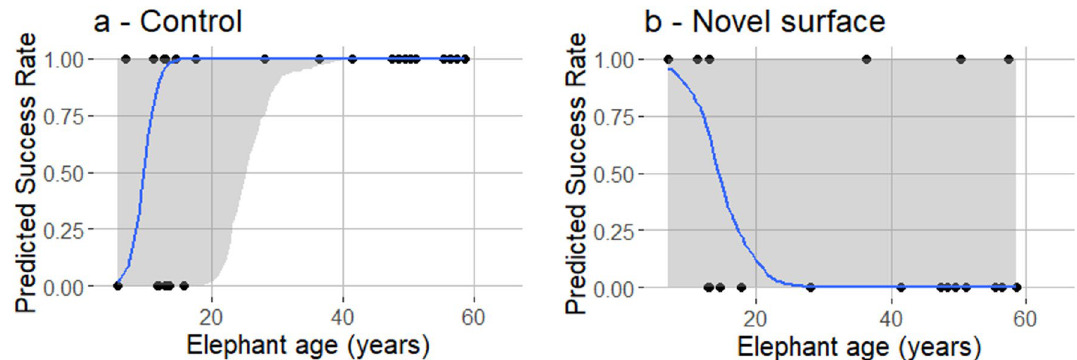
Figure 4. Predicted success rate depending on the task and elephant age (years), ( a ) control; ( b ) Novel Surface. Shaded areas show the 95% credibility intervals (Bayesian regression models 3 and 4 from Table